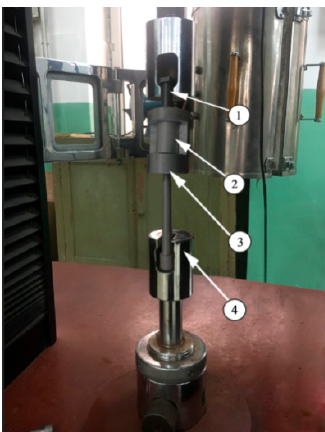
Figure 3. Tensile test device. 1—M12 × 1.25 screw; 2—Magnesium alloy; 3—Special tooling; 4—Cupping machine.